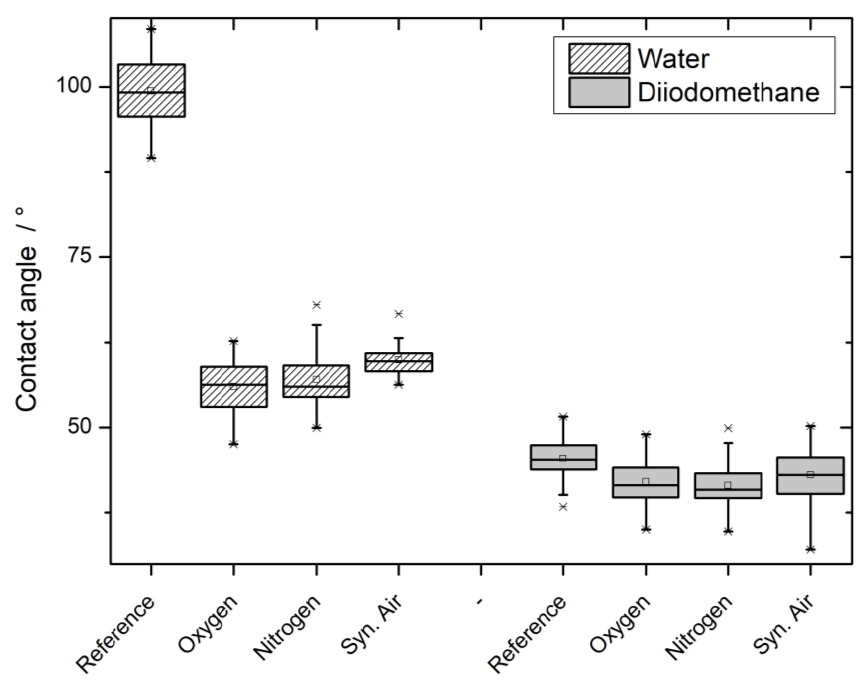
Figure 4. Contact angles of water and diiodomethane on PP60 before and after plasma treatment.